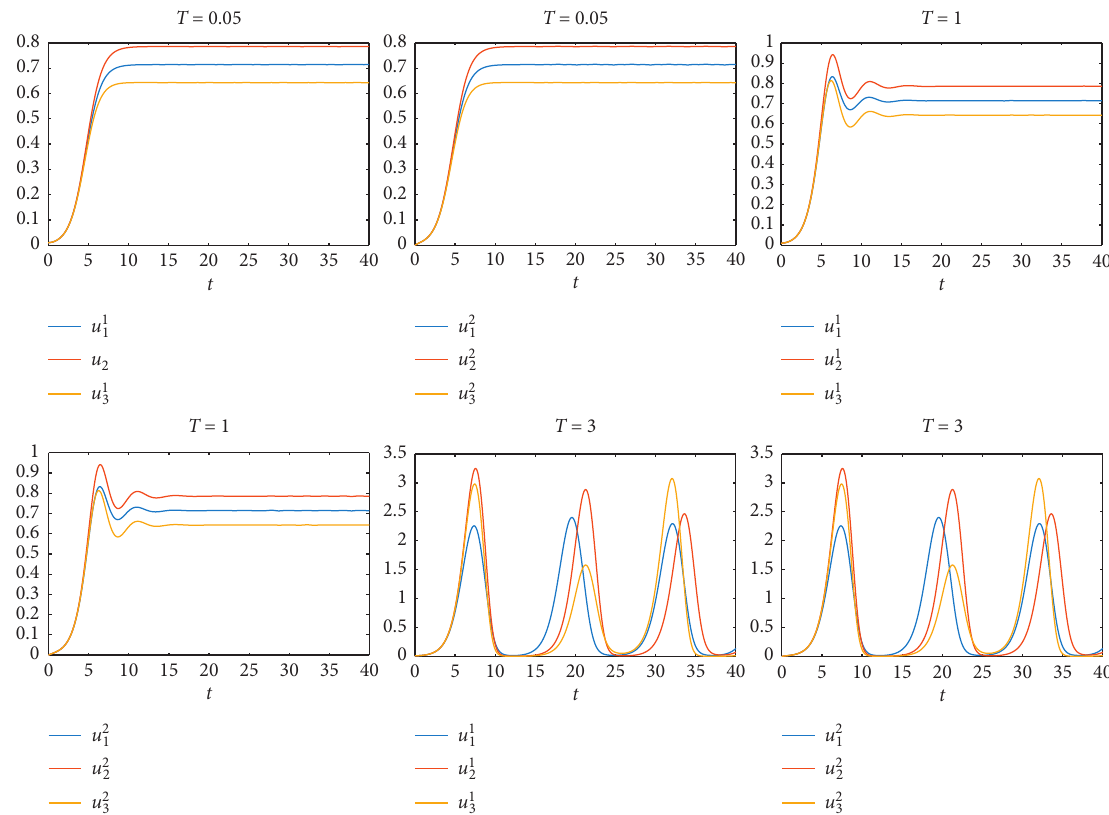
Figure 5: Simulation of (44) with (45) by taking different time